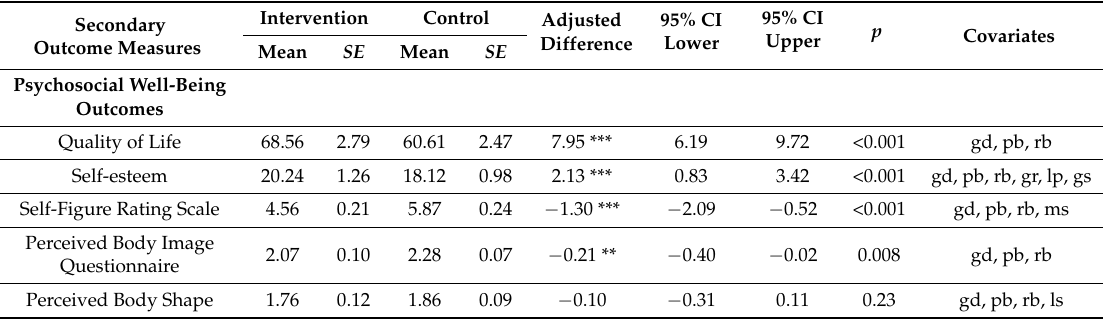
Table 5. Estimates of psychosocial impacts in complex sample general linear